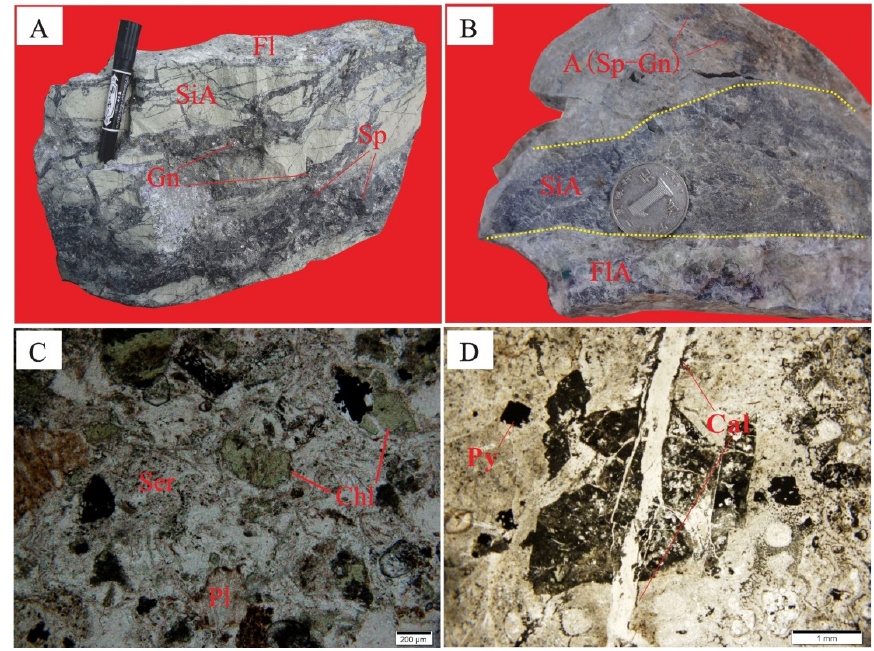
Figure 4. Alteration characteristics and micrographs of andesite and andesitic crystalline tuff of the Qiyimuchang lead zinc deposit. ( A )—Andesite (host rock) penetrated by veins; ( B )—Silicification and fluoritization alteration; ( C )—Chloritization in andesitic crystalline tuff (single-polarized transmitted light); ( D )—Later stage of carbonation, with visible carbonate veins cutting through amphibole(single polarized transmitted light); Py—pyrite; Gn—galena; Sp—sphalerite; Pl—plagioclase; Chl—chlorite; SiA—silicified andesite, Fl—fluorite, FlA—fluoritized andesite, A(Sp—Gn)—lead and zinc sulfide, Ser—sericite, Cal — carbonate.